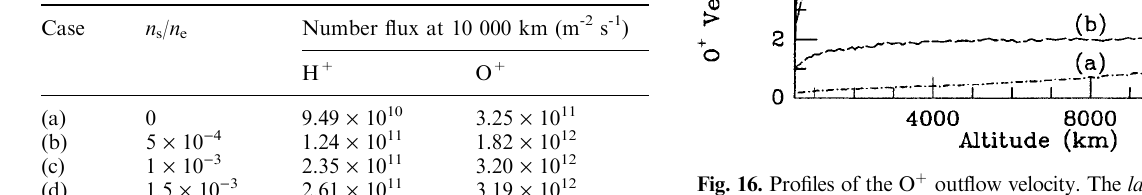
/ n at 500 km altitude, and s e